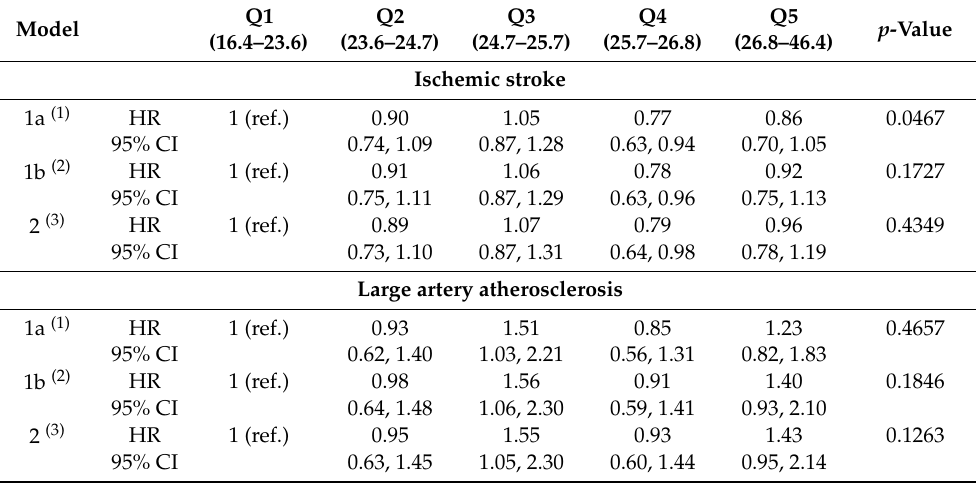
Table 2. Hazard ratios and 95% confidence intervals for associations for ischemic stroke and subtypes of ischemic stroke. The p -values listed are from testing the trend of the hazard ratios. The range of each quintile is given in parentheses ( ◦